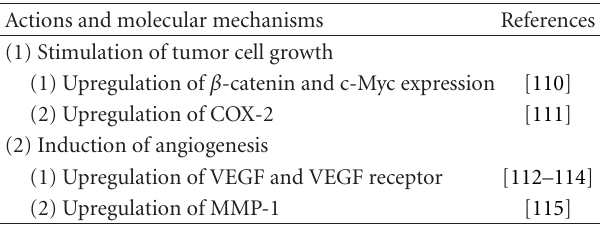
Table 2: Potential molecular mechanisms for procarcinogenic activity of PPAR γ